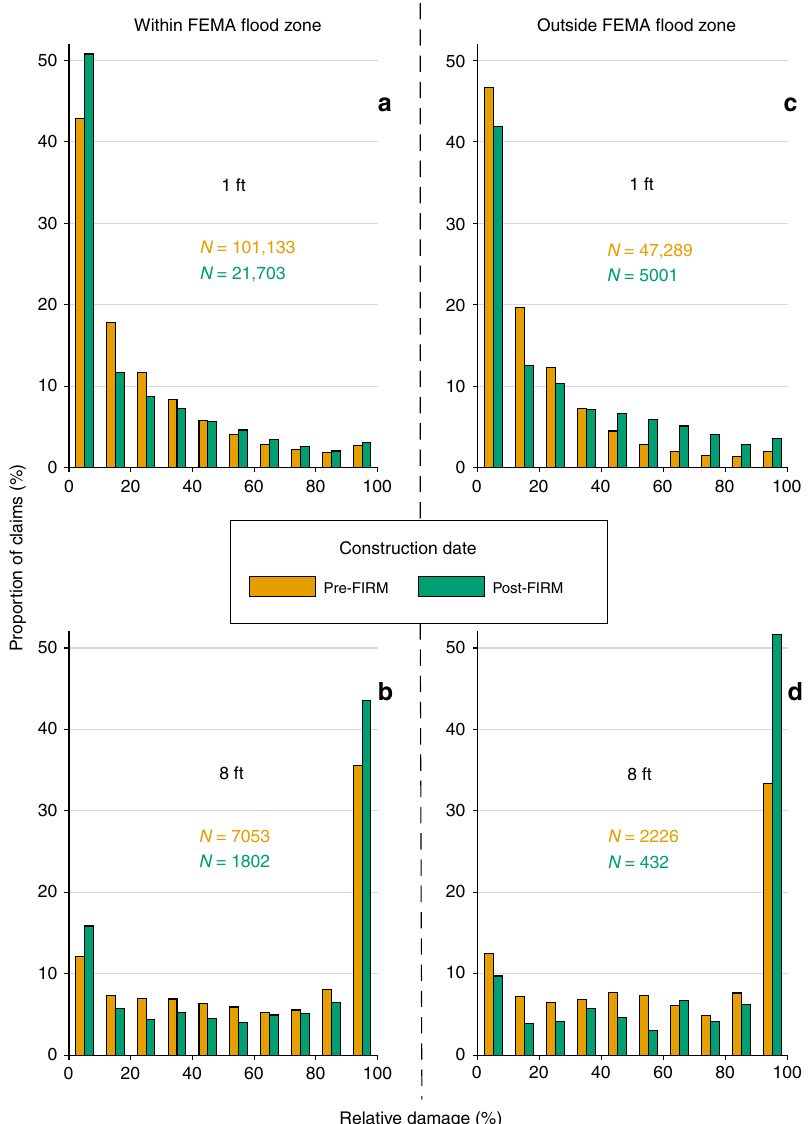
Fig. 5 Relative damage to buildings that are situated within vs. outside of FIRMs before vs. after their initial publication. Selected results are shown for claims arising from one-story residential structures with no basement within the FEMA 100-year fl ood zones for 1 ( a ) and 8 ( b ) feet of inundation and the same but for properties outside of the FEMA fl ood zone for 1 ( c ) and 8 ( d ) feet of